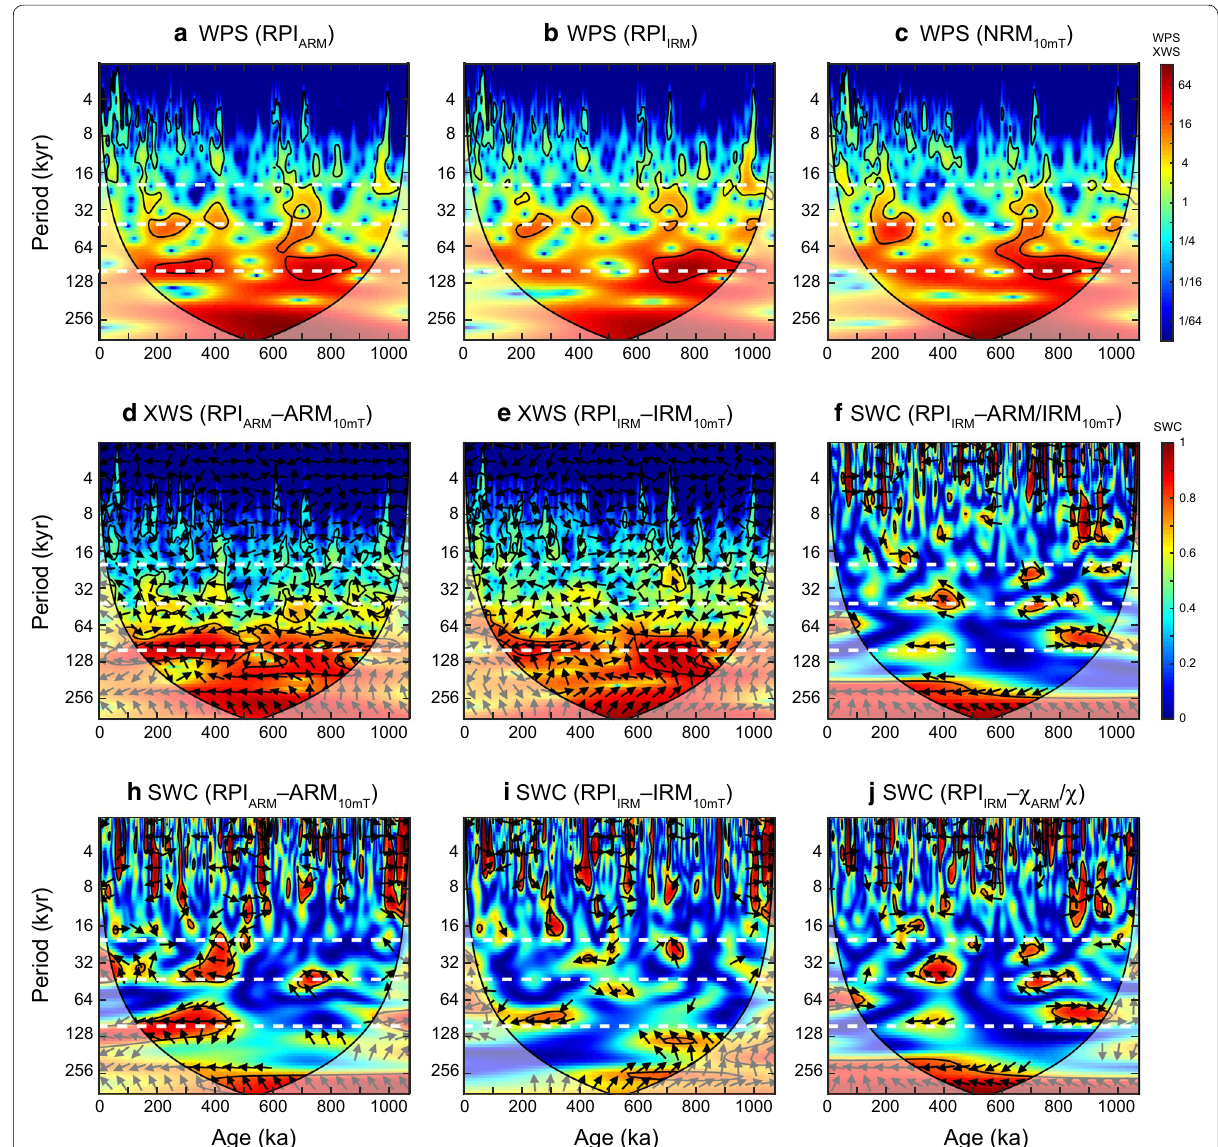
Fig. 8 Results of a – c wavelet power spectra (WPS), d – e cross-wavelet spectra (XWS), and f – j squared wavelet coherence (SWC). NRM 10mT , ARM 10mT , and IRM 10mT are the remanences demagnetized in a 10 mT AF field. The 100-kyr, 41-kyr, and 23-kyr orbital periods are marked as horizontal white dashed lines. The black contour represents the 95% significance level, and the lighter shade indicates the cone of influence where the wavelet spectra may be distorted by edge effects. Arrows in diagrams represent the relative phasing of two time series: right-pointing, left-pointing, and non-horizontal arrows indicate in-phase, anti-phase, and out of phase,